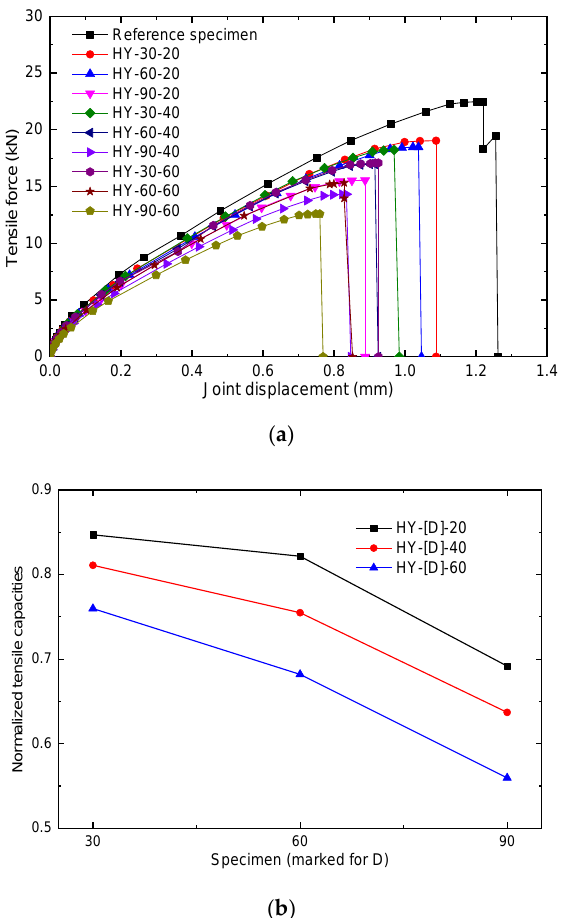
Figure 7. Specimens of hygrothermal conditions (HY) series. ( a ) Load–Displacement Curves; ( b ) Normalized Tensile Capacities.